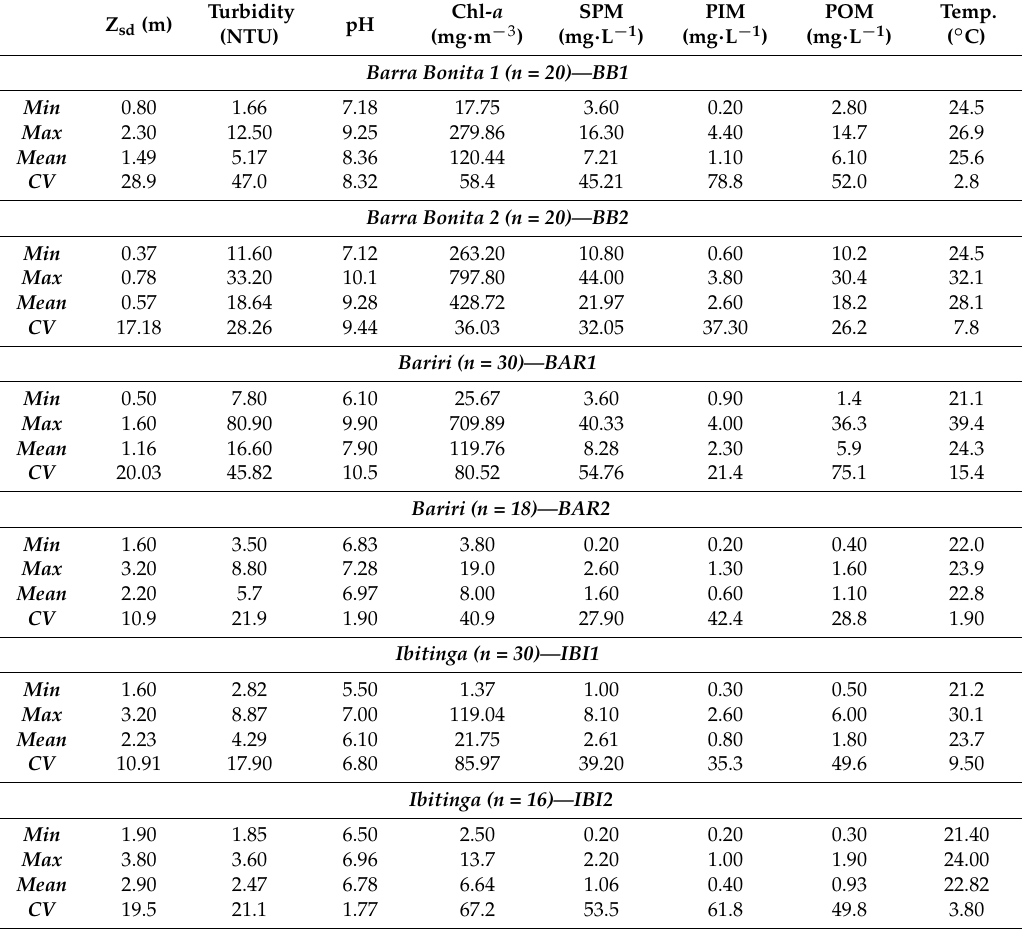
Table 1. Descriptive statistics of water quality parameters in BB, BAR, IBI, and NAV from two field campaigns. Here Min, Max, SD, and CV represent the minimum, maximum, standard deviation, and coefficient of variation (in %), respectively. Zsd is the Secchi Disk Depth (m), SPM is suspended particle